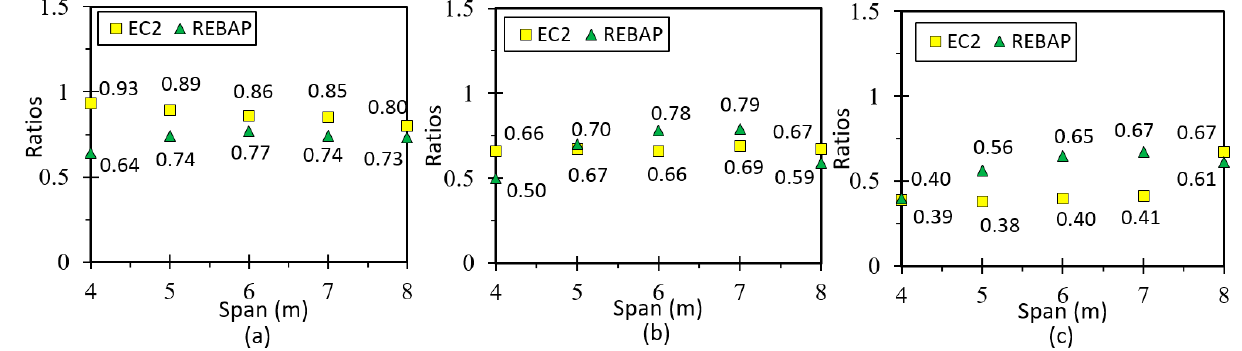
Figure 26. Ratios values for ( a ) LM, ( b ) 1NLM and ( c ) 2NLM, for supported beam.